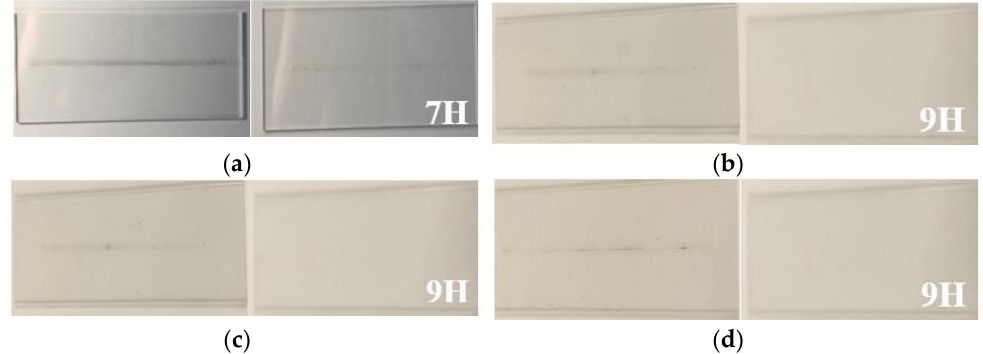
Figure 6. Hardness characteristics according to the number of coating and annealing: ( a ) natural drying, ( b ) one step, ( c ) two steps, and ( d ) three steps.